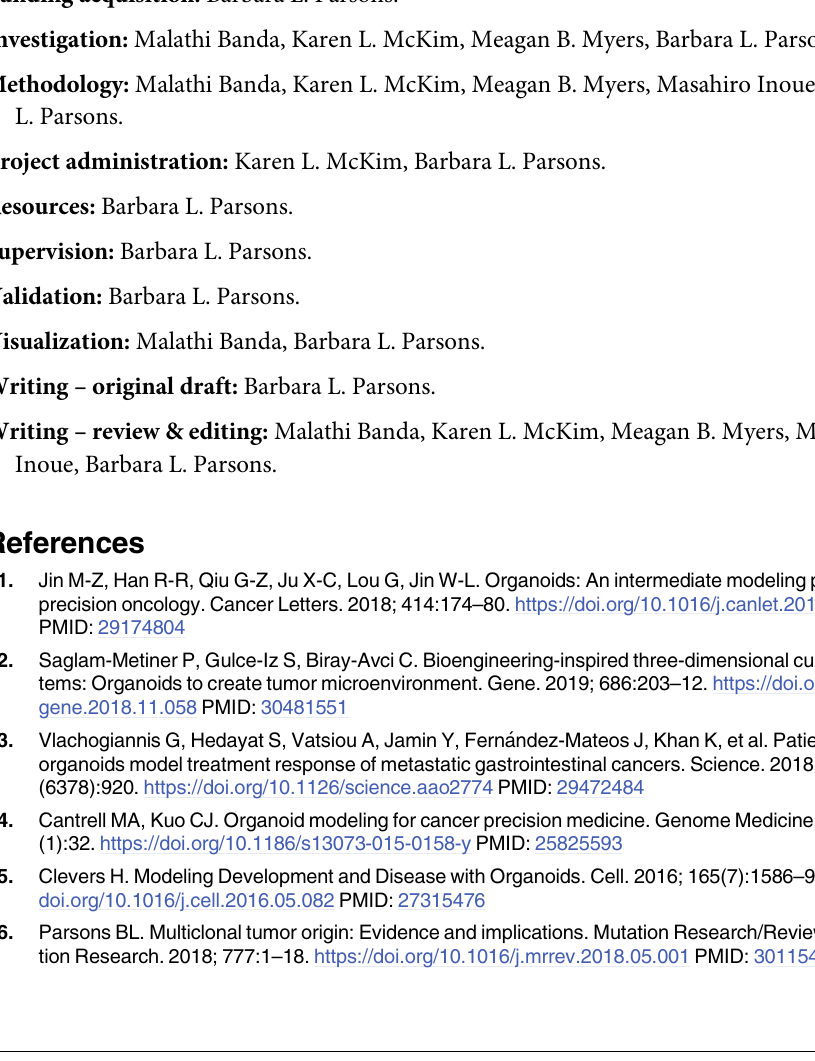
S14 Fig. Additional examples of organoid morphologies. The organoids shown were cul- tured from Tumor 12 (panel A), Tumor 13 (panels B and F), Tumor 14 (panels C, D and E). The scale bar in panels A, B, D, E and F is 100 μ m. The scale bar in panel C is 200 μ m. D and E show organoids that appear to have attached to the bottom of the plate and grown primarily as 2D cultures.